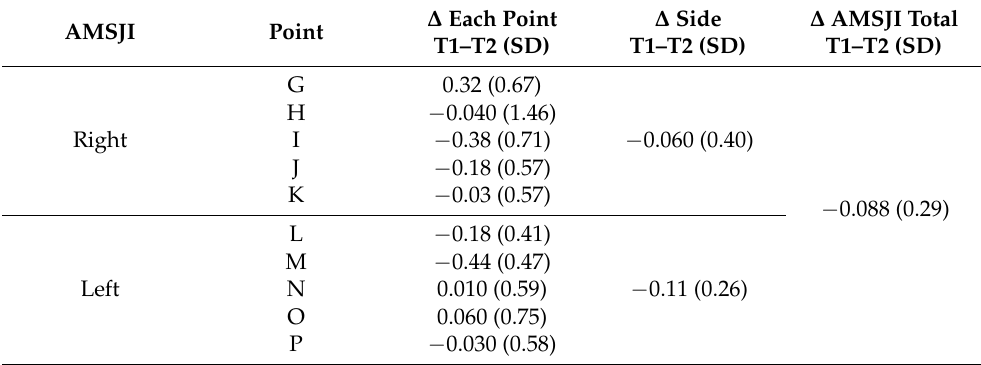
Table 2. Effect of the AMSJI wings and basal frame on the underlying zygomaxillary bone (in mm). A negative value indicates a mean resorption, and a positive value indicates a mean